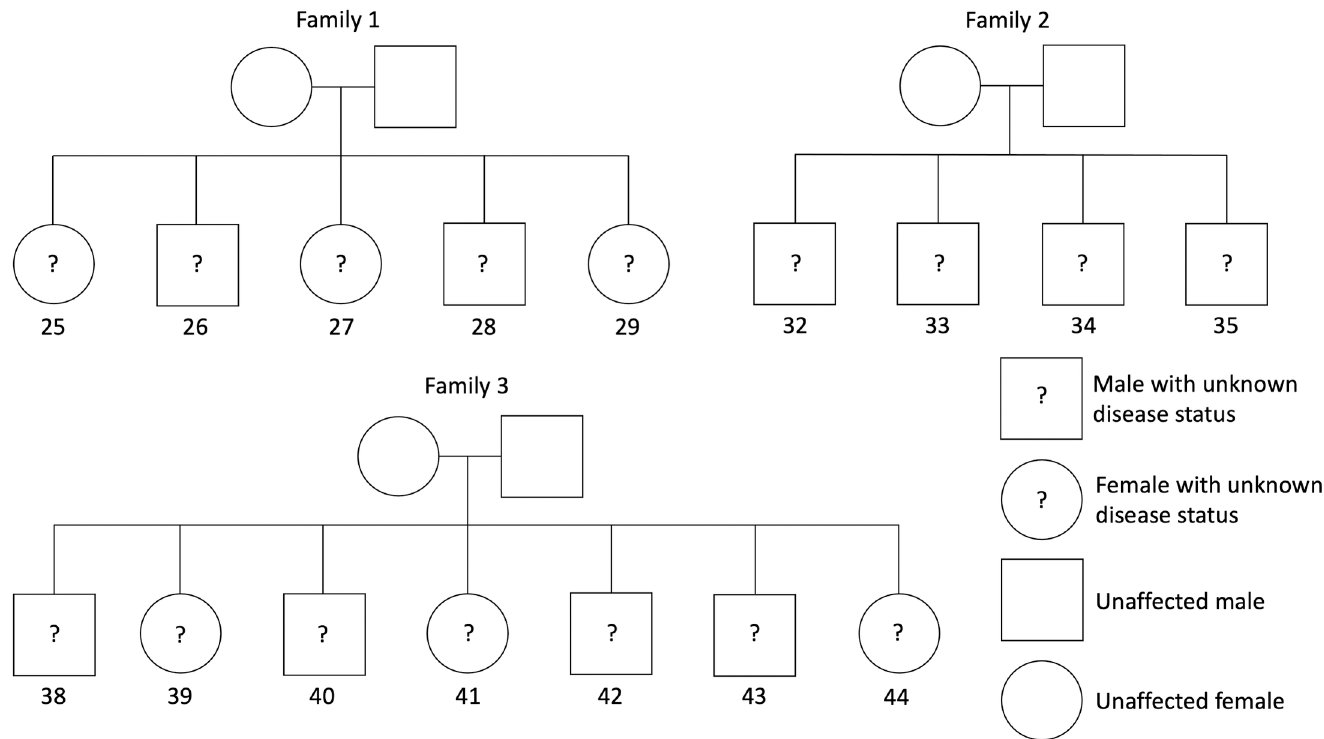
Fig 1. Structure of each nuclear family. Each diagram in this figure represents one family from our study. In each diagram, shapes at the top represent parents; shapes at the bottom represent children. Numbers below children are sample identifiers. These identifiers do not necessarily correspond to birth order or any other factor. One child in each family had been diagnosed with pediatric cancer, but the disease status of all children was unknown to the primary author until after disease- history predictions were made. This unknown status is represented using question marks.